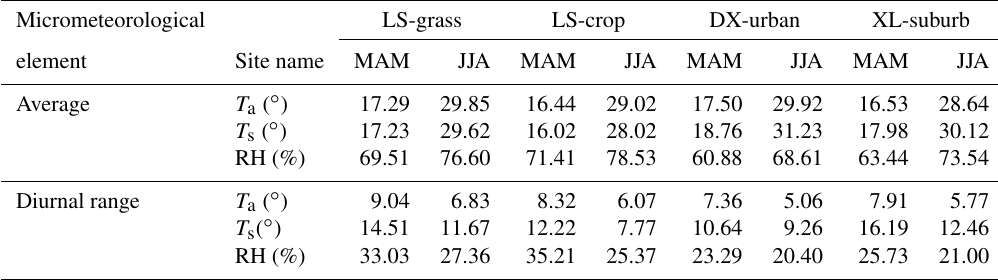
Table 2. Seasonal averages of air temperature, surface temperature, and relative humidity at the four sites. Micrometeorological LS-grass LS-crop DX-urban XL-suburb